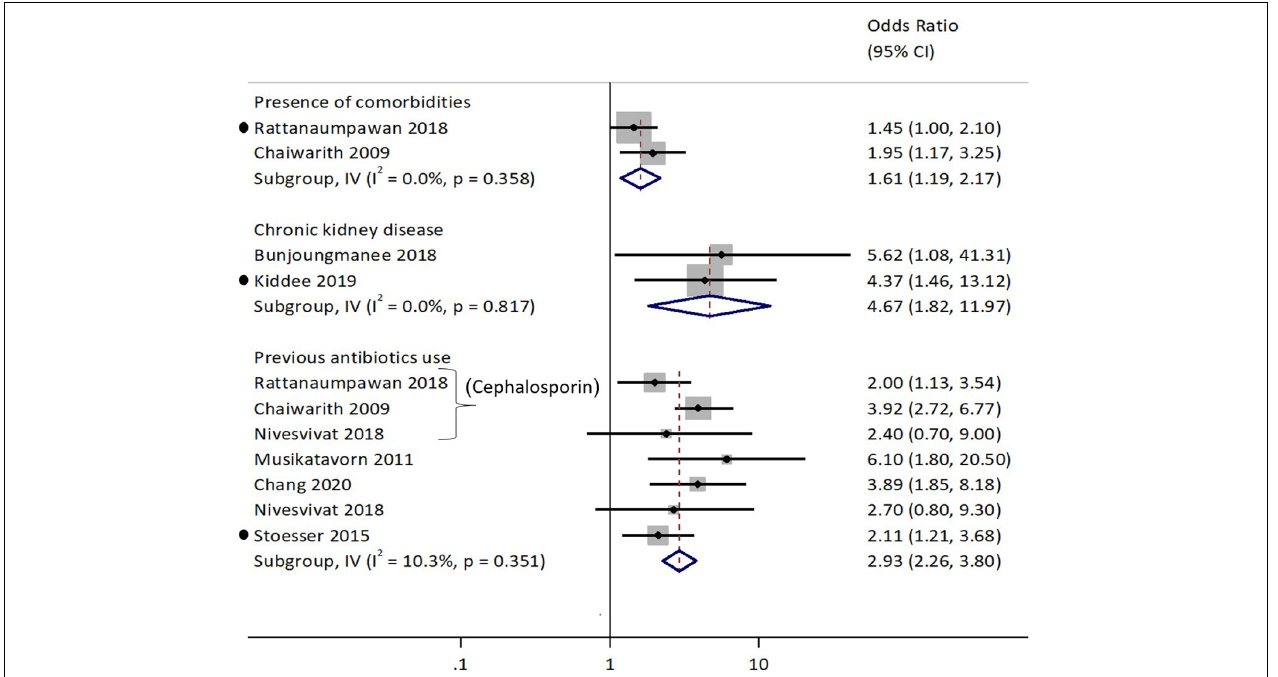
FIGURE 8 | Forest plot for previous antibiotics consumption as a risk factor associated with ESBL- E. coli. Carriage studies. Forest plots from the random-effects meta-analyses of studies showing the individual and pooled odds ratios for the association between (1) previous fluroquinolone use (top half) and (2) previous antibiotics use (bottom half) and the isolation of E. coli (ESBL-Ec) from clinical and non-clinical specimens. The gray shaded box on the individual point estimates represents the relative weight of each individual study contributes to the pooled